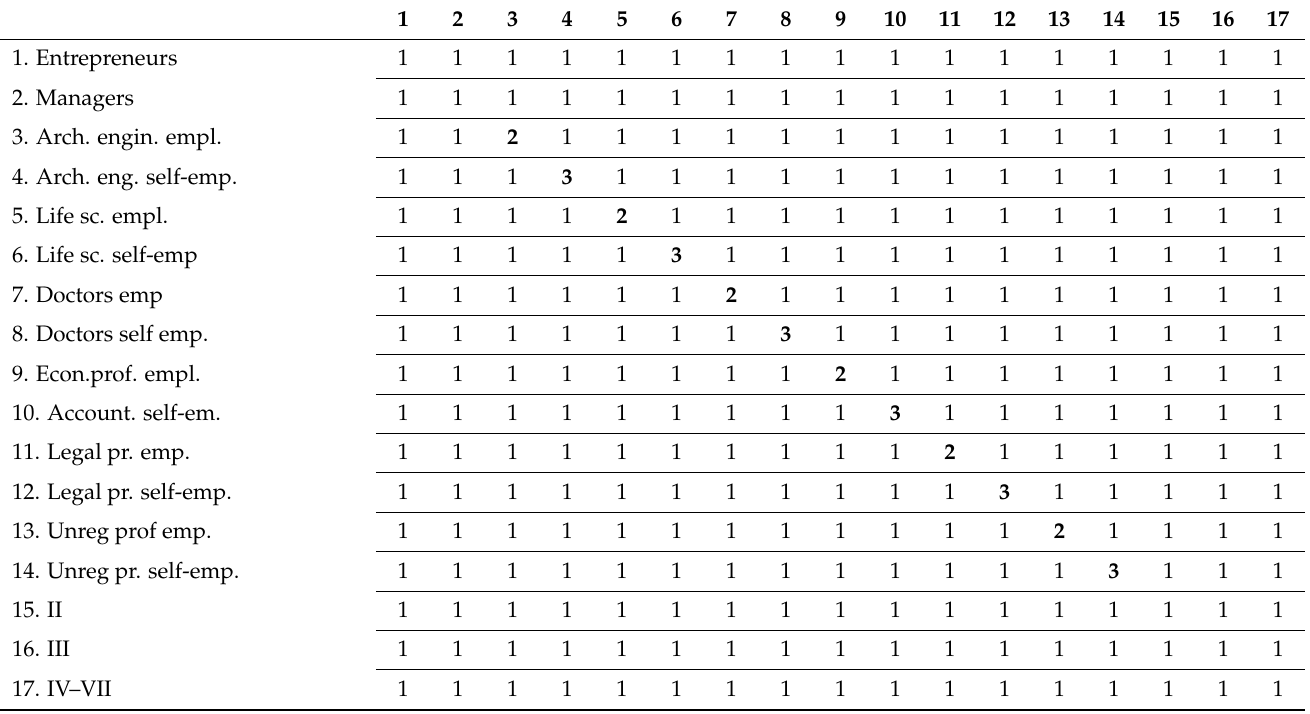
Table A5. Employed and self-employed professionals—Model 5a and